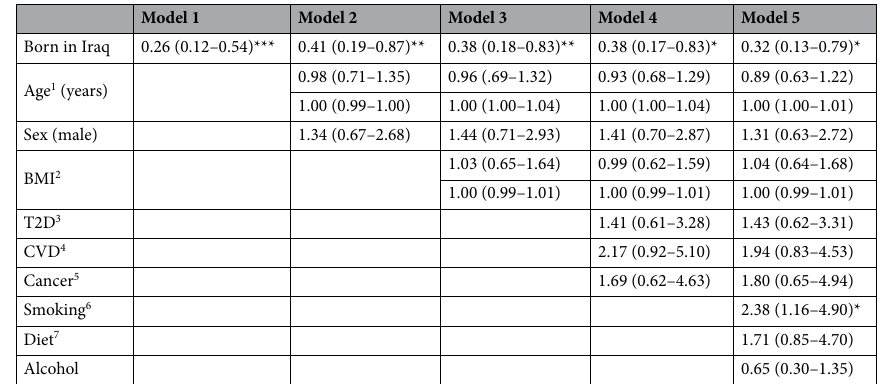
Table 2. Cox regression models showing adjusted HR of ACM, Model 1–5, 95.0% CI for Exp(B). 1 Linear age and age squared, 2 linear BMI and BMI squared, 3 T2D at baseline, 4 CVD at baseline, 5 cancer disease at baseline, 6 current tobacco smoking, 7 daily intake of fruit, berries and/or vegetables, p < 0.05*, p < 0.01**, p < 0.001***.